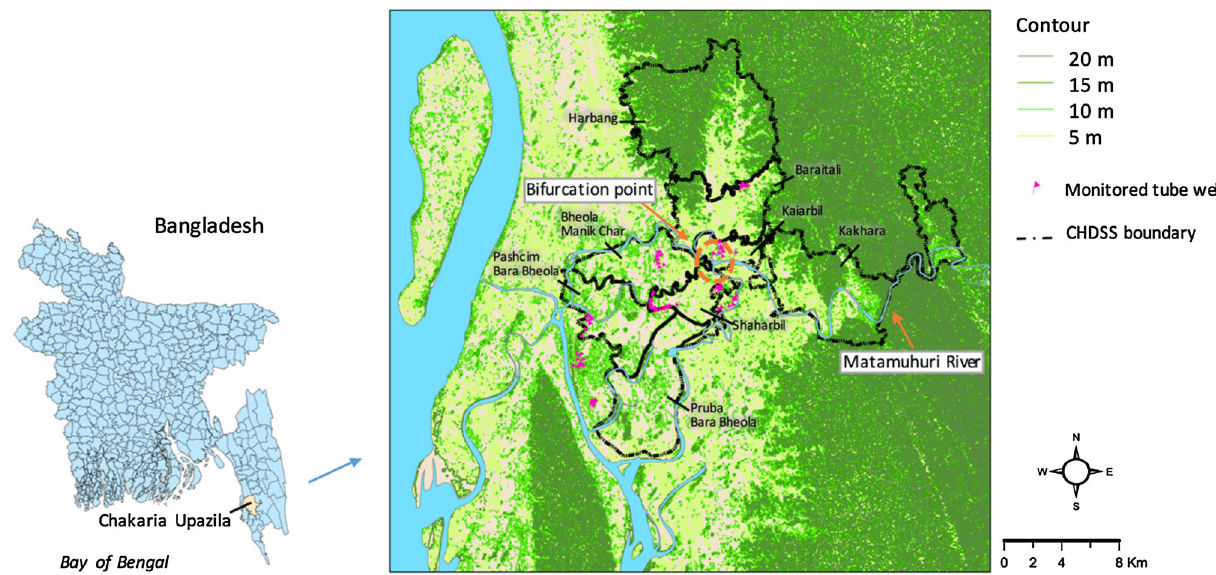
Fig. 1 Location of the study area and the monitored tube wells in Chakaria Upazila, Cox’s Bazar District, Bangladesh